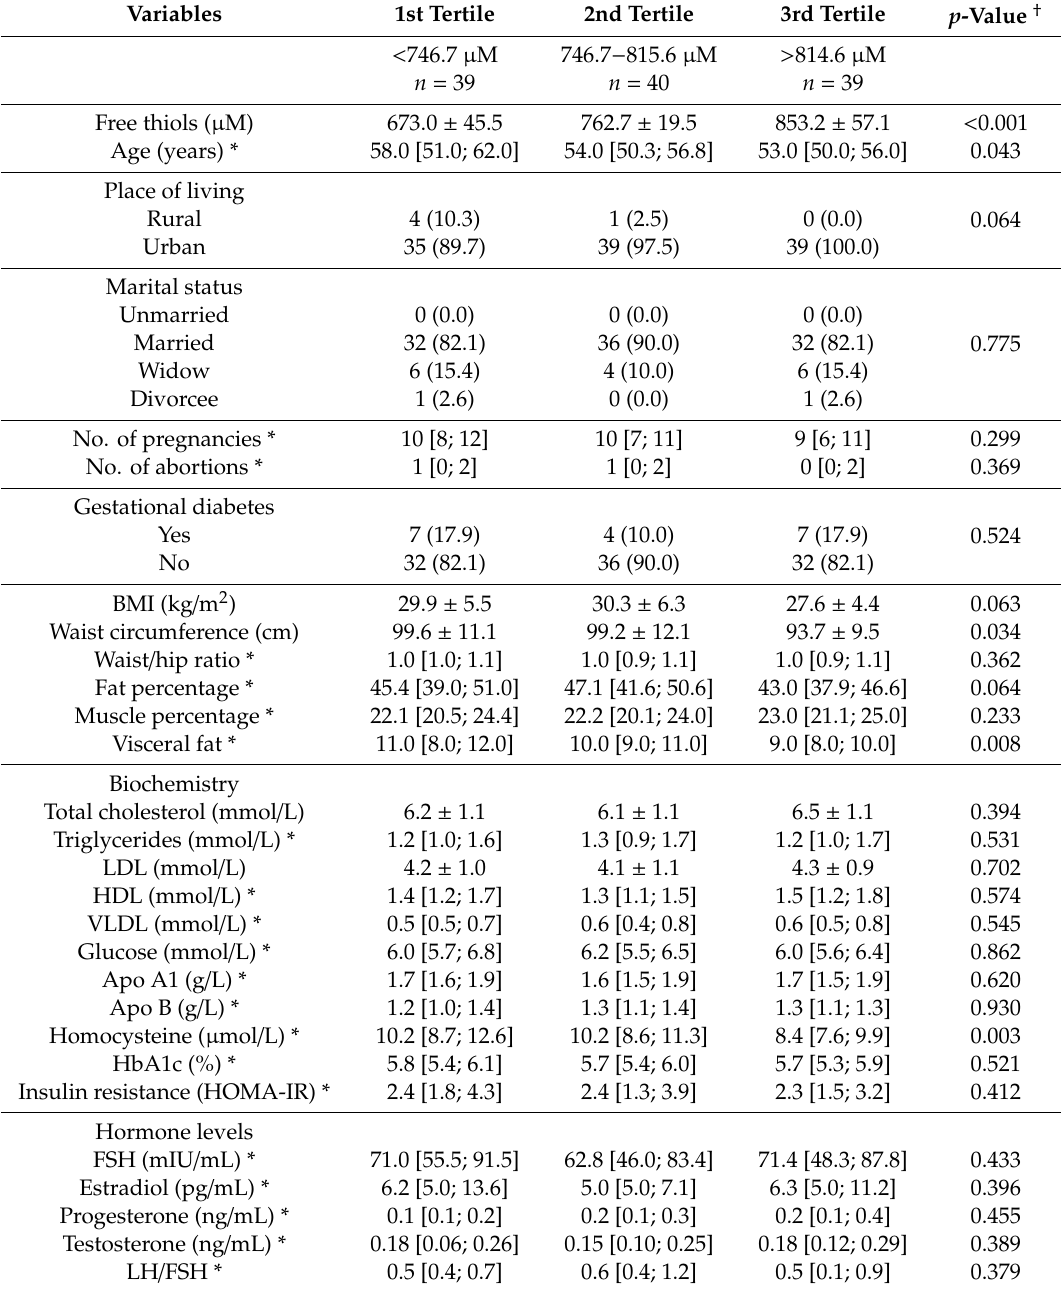
Table 2. Cohort characteristics of menopausal women ( n = 118) with comparison between tertiles of serum free thiol